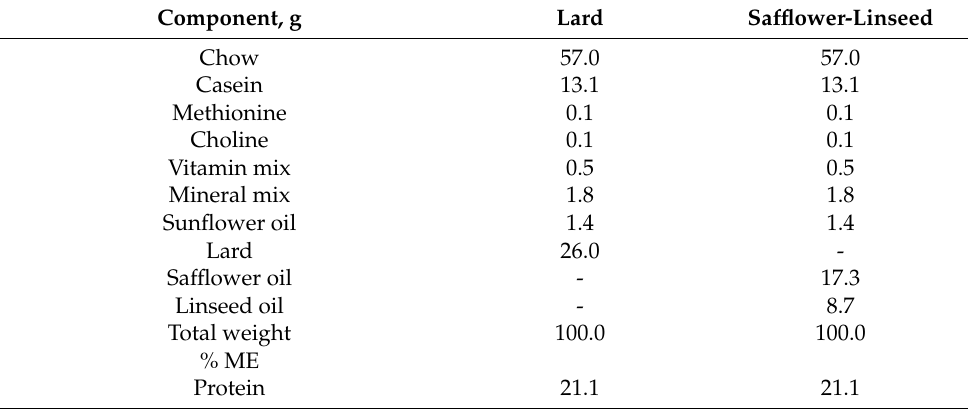
Table 1. Composition of experimental